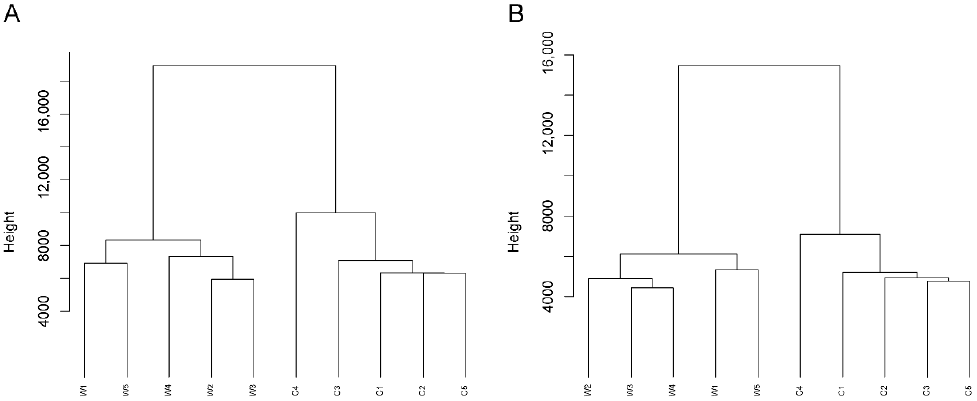
Figure 3. HCA dendrograms of the metabolites acquired from positive ( A ) and negative ( B ) ioniza- tion modes.